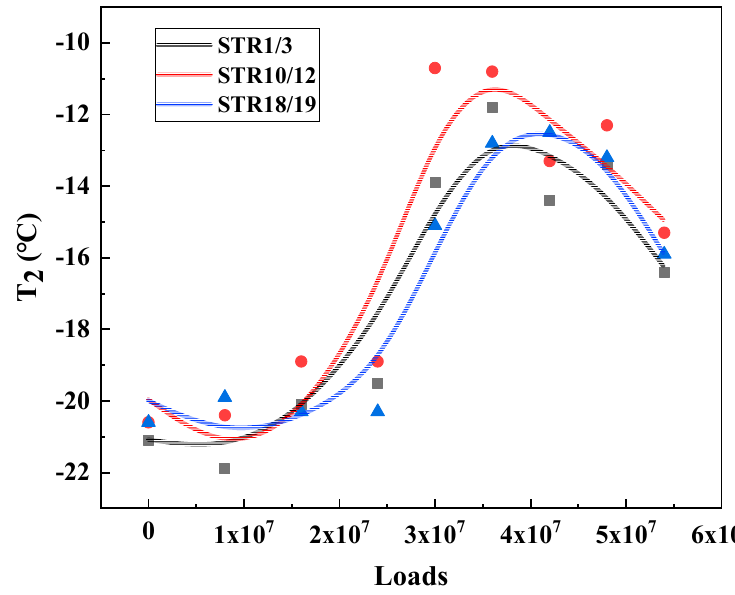
Figure 15. Characteristic temperature T 2 for the three types of structures.